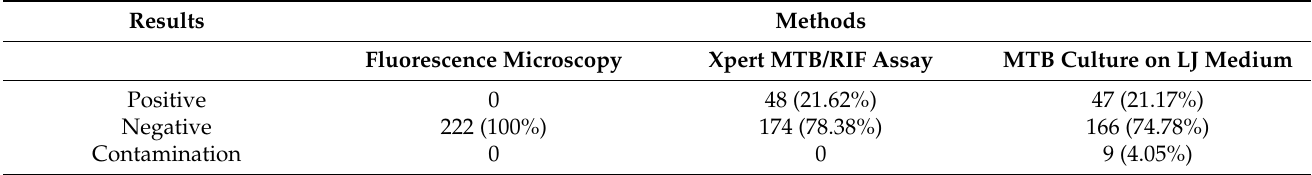
Table 1. Comparison between Fluorescence AFB Sputum Smear Microscopy, Xpert MTB/RIF Assay